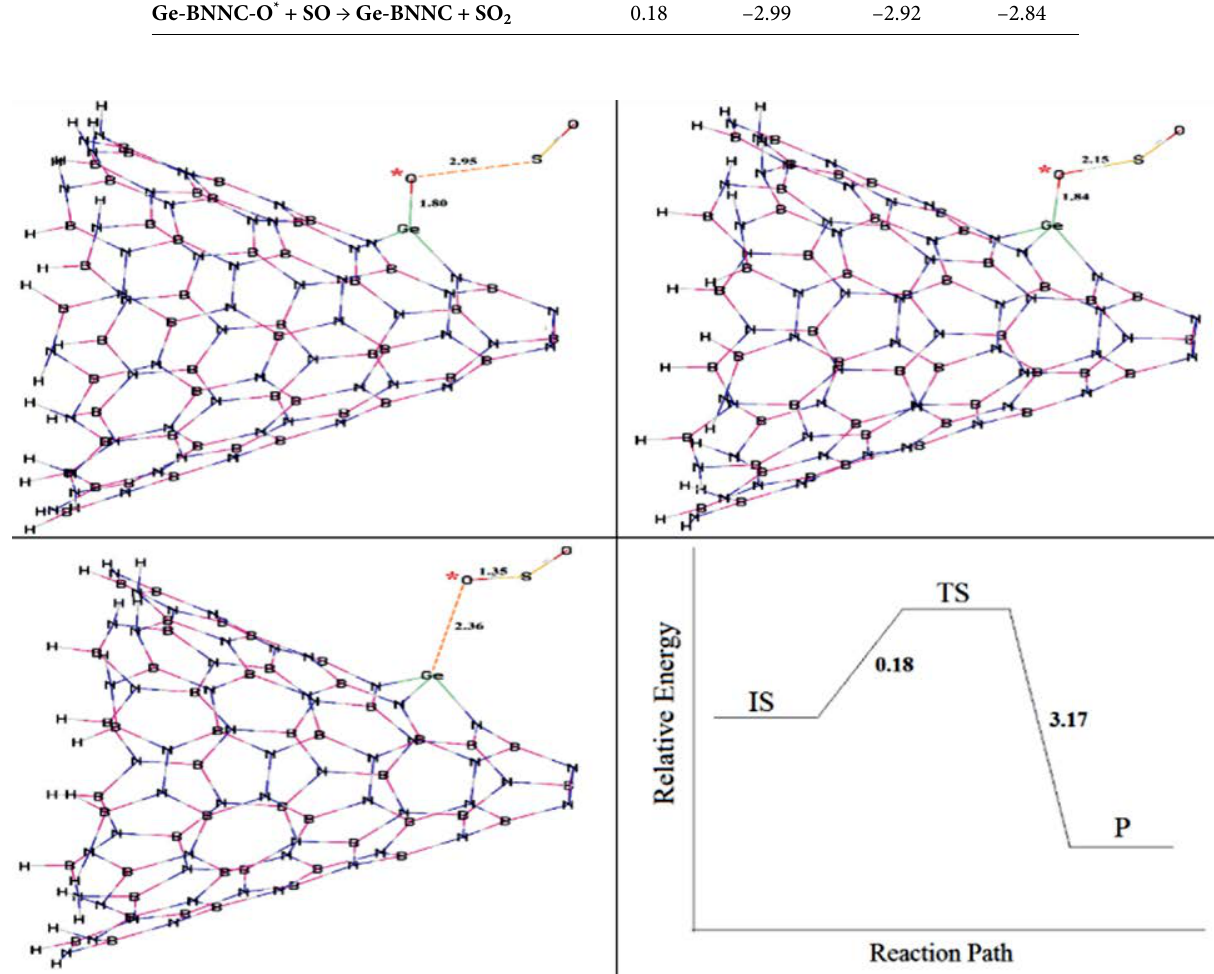
Figure 3. Plan of Ge-BNNC-O * + SO → Ge-BNNC + SO 2 reaction (Bond distances (Å) and relative energies